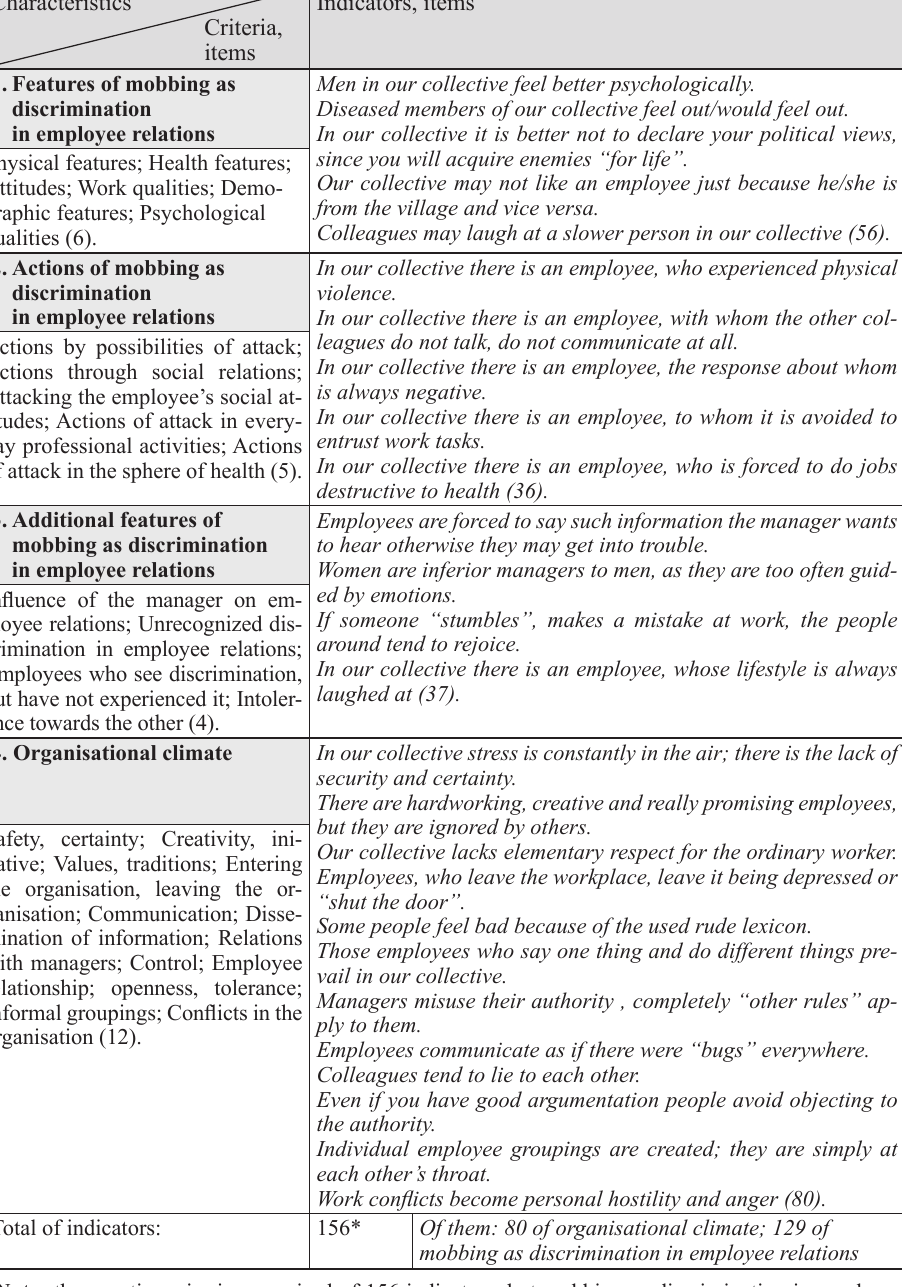
Table 4. Fragment of characteristics, criteria and indicators of the instrument